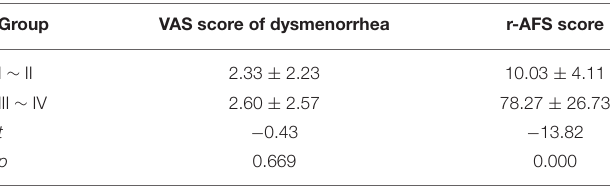
TABLE 5 | Comparison of VAS score of dysmenorrhea and r-AFS